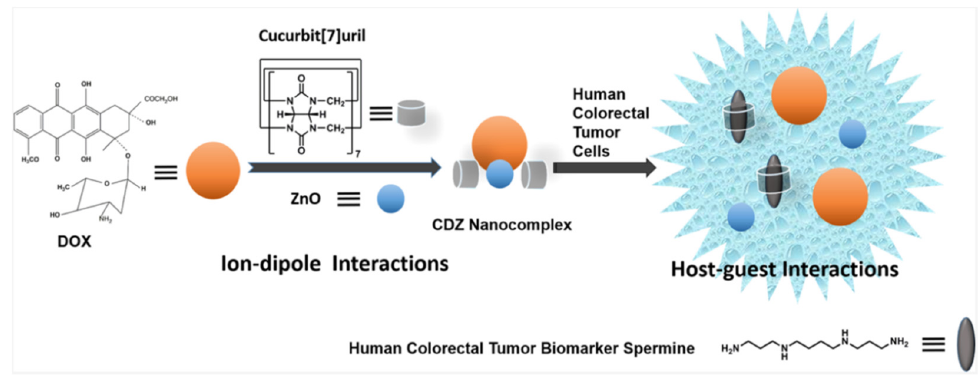
Figure 18. Illustration of DOX, ZnO, and CB[7] connections and drug delivery system (reproduced with permission of American Chemical Society from ref. [95]).